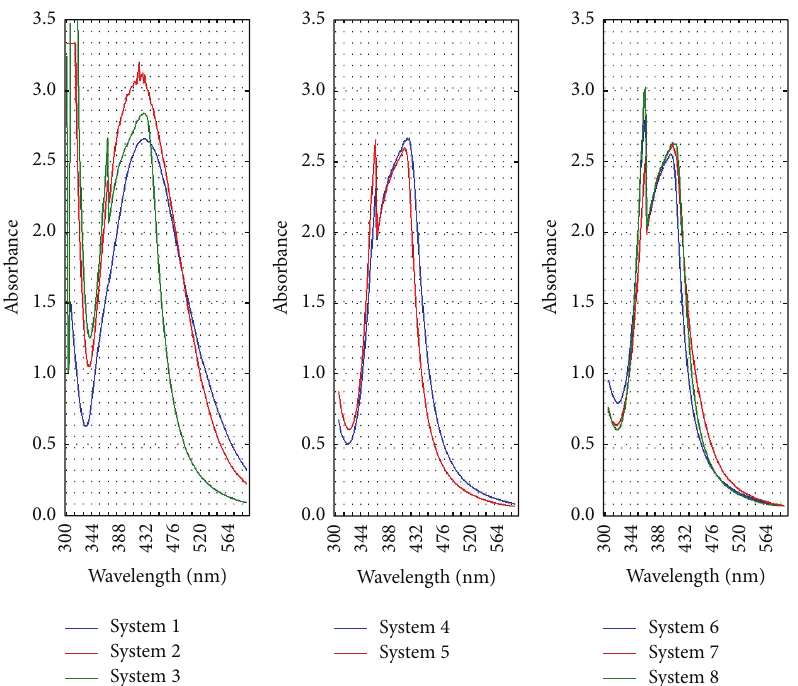
Figure 1: The absorption spectra obtained for the respective suspensions of silver nanoparticles (diluted to 50mg/dm 3 ).